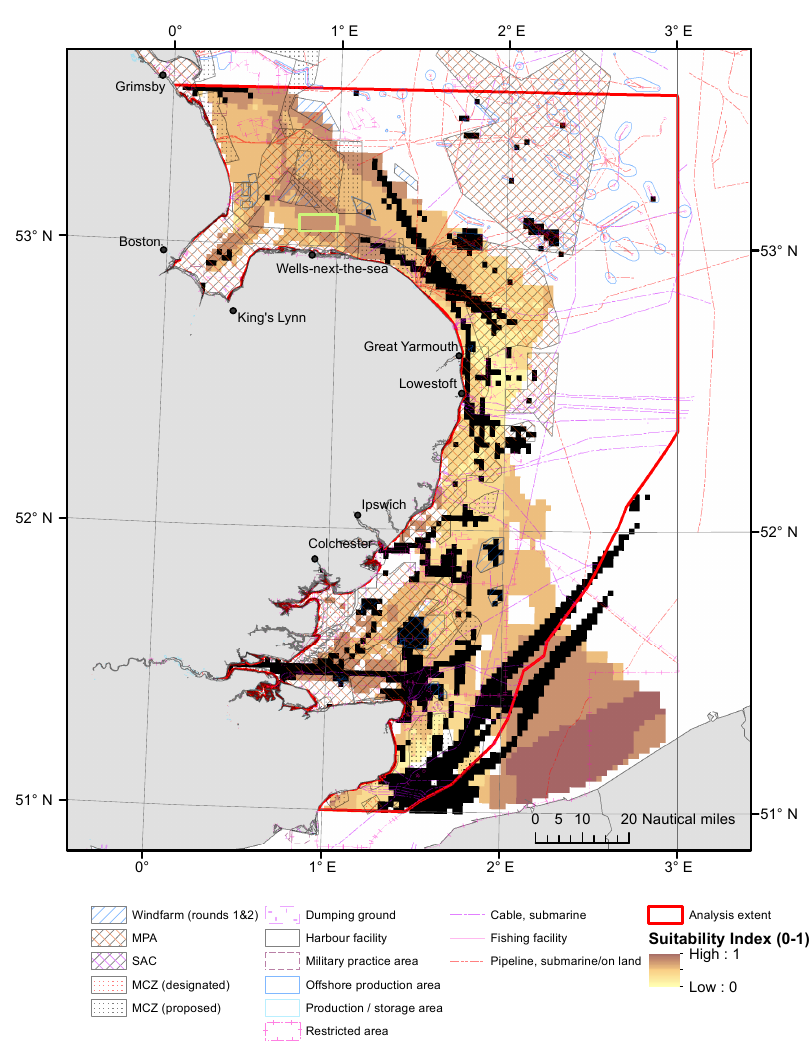
Figure 3. Potential areas for a commercial farm off the north Norfolk coast. Yellow to brown shading: suitability index. Black: moderately high to high shipping intensity (derived from marine vessel automatic identification system ping data obtained from exactEarth Ltd., http: //www.exactearth.com/, for the year 2013). Lines and hashes: various licensed use (obtained on request from the Joint Nature Conservation Committee (JNCC) in 2011 based on the Marine Reference data set, Defra). Green rectangle: selected farm